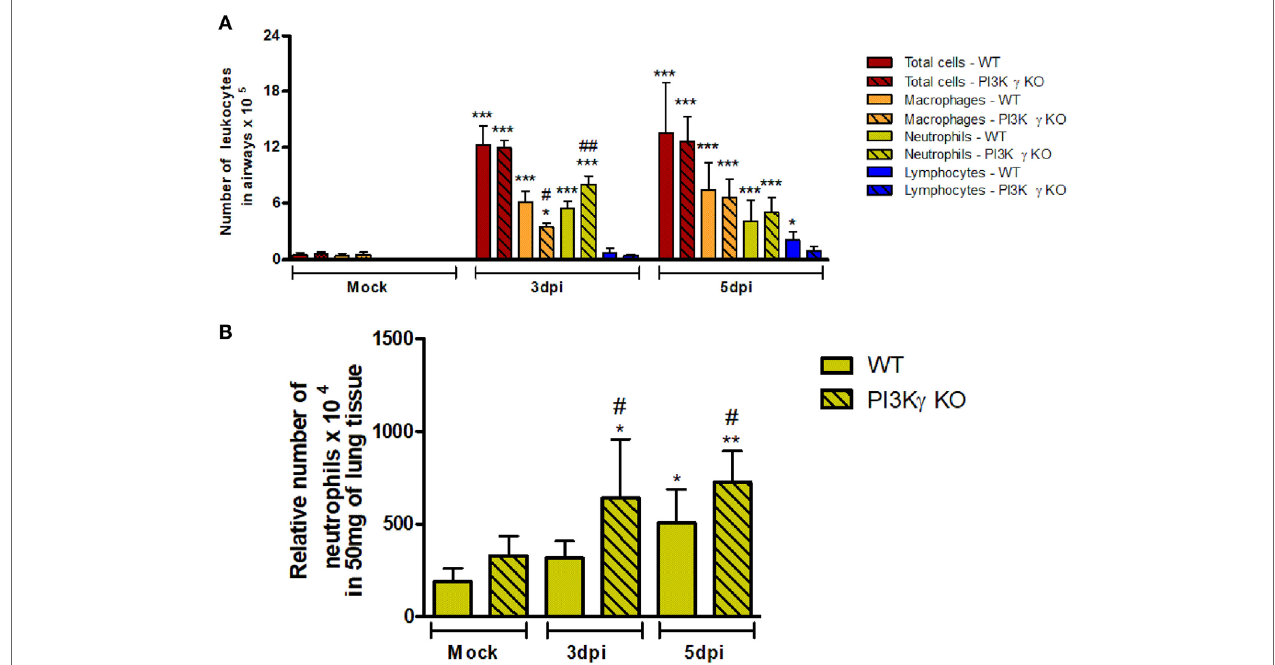
FigUre 2 | Early leukocyte recruitment to the airways and neutrophil recruitment to the lungs during influenza A virus infection are more pronounced in phosphatidyl inositol 3 kinase-gamma (PI3K γ ) knockout (KO) mice. WT and PI3K γ KO mice were infected with WSN or phosphate-buffered saline (Mock control) and killed at days 3 and 5 after infection ( n = 4–8 mice per group and time point). (a) Bronchoalveolar lavage was performed to assess recruitment of total leukocytes (red columns), macrophages (orange columns), neutrophils (yellow columns), and lymphocytes (blue columns) to the airways in cytospin stained slides. (B) Recruitment of neutrophils to the lungs was assessed by myeloperoxidase assay. Cell numbers are presented as mean ± SD. * p < 0.05, ** p < 0.01, and *** p < 0.001, comparing to Mock or indicated groups and # p < 0.05, ## p < 0.01, and ### p < 0.001, when compared with WT control in the same time point (one-way ANOVA,